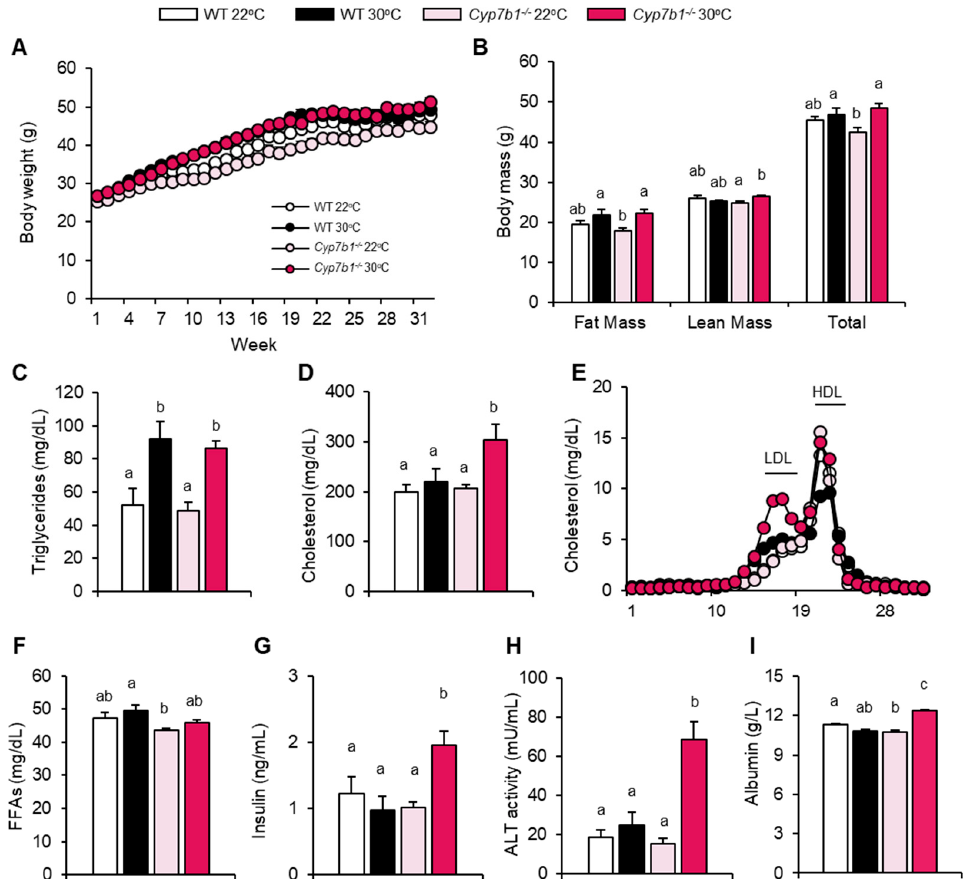
Figure 1. CYP7B1-deficiency induces MAFLD-associated metabolic parameters at thermoneutral housing conditions. Cyp7b1 − / − and WT littermates housed under 22 ◦ C or 30 ◦ C were fed a CD-HFD for 8 months. ( A ) Body weights. ( B ) Body composition analysis by echoMRI. ( C ) Triglycerides, ( D ) cholesterol, ( E ) cholesterol in FPLC fractions, ( F ) free fatty acids (FFA), ( G ) insulin, ( H ) alanine aminotransferase (ALT) activity, and ( I ) albumin in plasma collected at the end of the feeding study. Data are shown as mean values ± SEM (number of mice: WT 22 ◦ C: n = 11; WT 30 ◦ C: n = 9; Cyp7b1 − / − 22 ◦ C: n = 16; Cyp7b1 − / − 30 ◦ C: n = 13). Different letters indicate significant differences between groups ( p < 0.05) determined by two-way ANOVA.